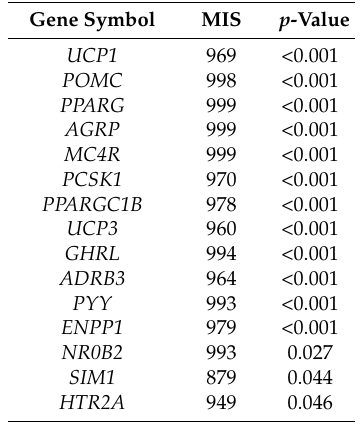
Table 2. Information on important disease genes of